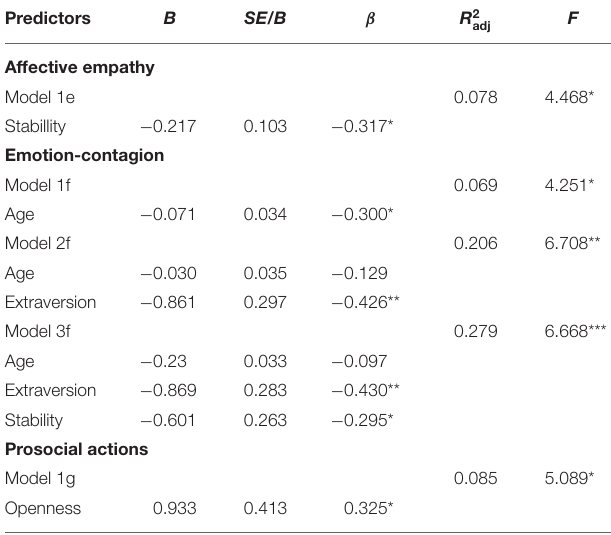
TABLE 4 | Predictors of children’s empathy skills as perceived by Mothers according to children’s individual characteristics. Predictors